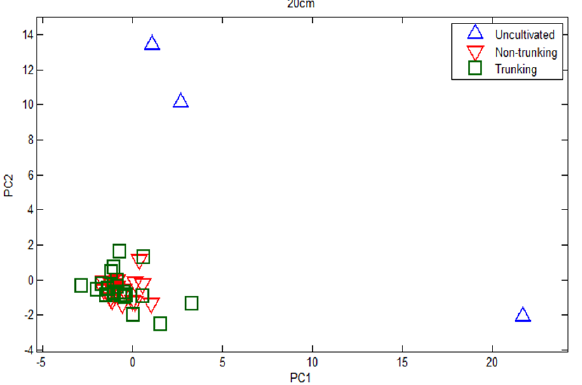
Figure 3. The FTIR profiles of uncultivated peat (bottom trace), and cultivated peat sampled adjacent to non-trunking (middle trace) and trunking (top trace) sago palms.